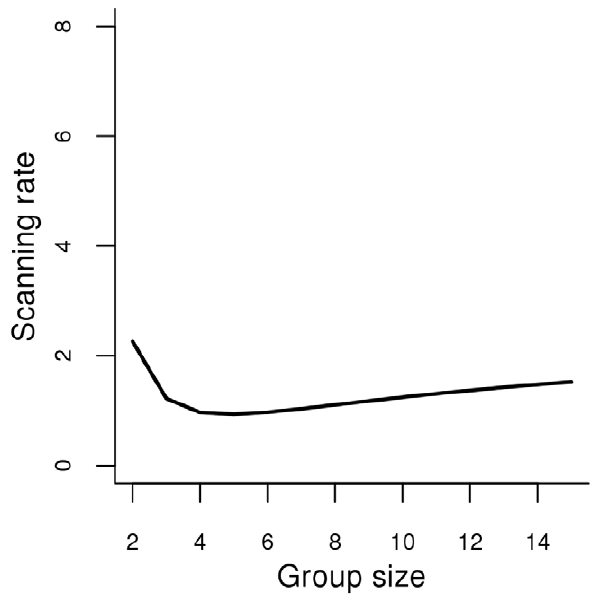
Figure 1. Changes in scanning rates (vigilant acts per minute) as a function of group size for mothers according to the